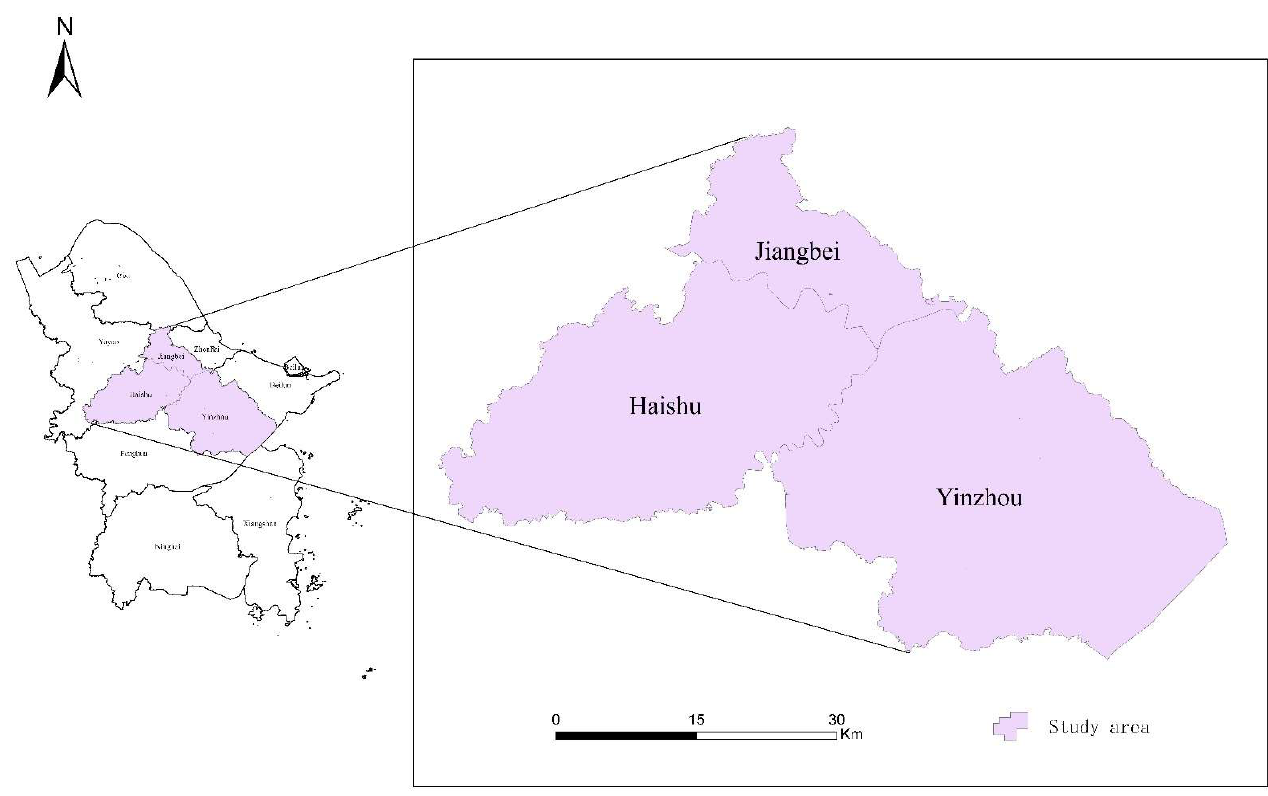
Figure 1. Study Figure 1. Study area.